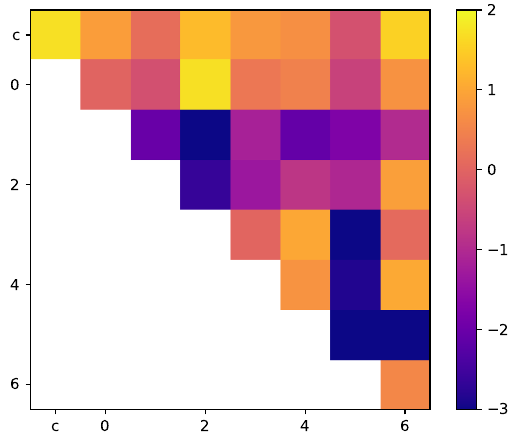
Figure 13 . A heatmap showing log ( j c j ) for each coe(cid:14)cient c in the formula, after rescaling each 10 variable to have expectation value 1. The top row corresponds to the constant term (top left square) and the linear